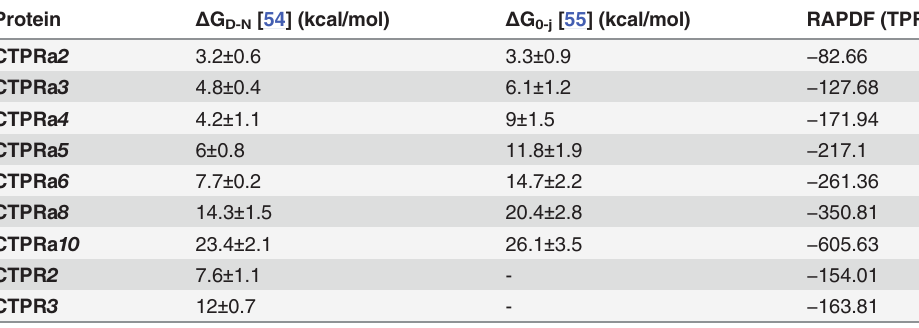
Table 2. Comparison of kinetic energies and RAPDF scores of TPR